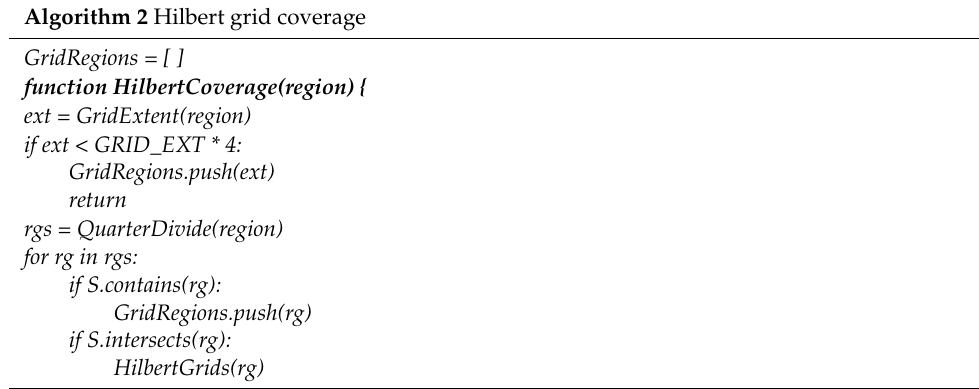
Algorithm 2 Hilbert grid coverage